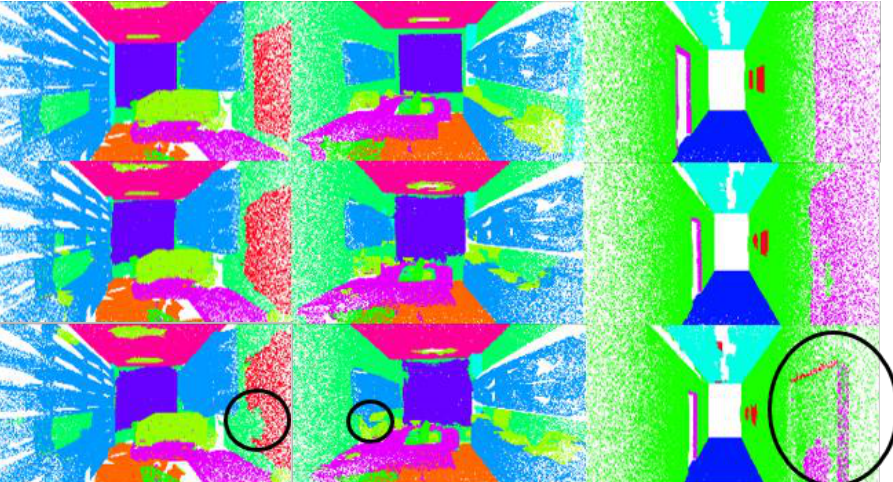
Figure 12. Visualization results. First row is the ground truth. Second row shows the results when using the improved local transformer block. The third row shows the results when using the original local transformer block.